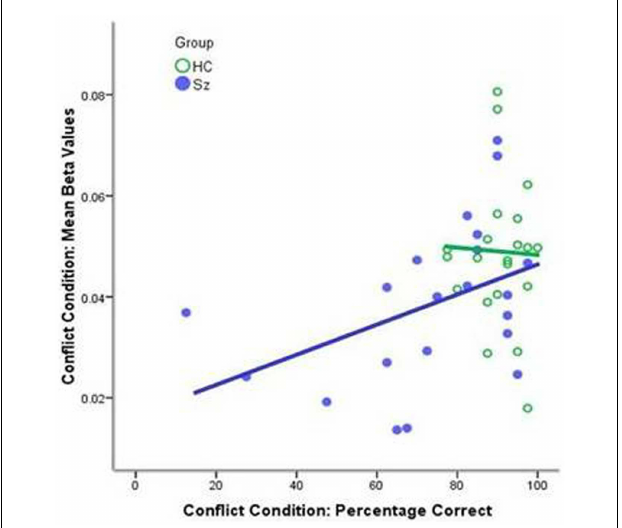
FIGURE 3 | Correlations between performance on the conflict condition and the mean beta values for the conflict condition for the whole mask .The schizophrenia group showed a significant correlation [ r (21) = 0.422; p < 0.05, blue line]; the healthy control group displayed uniformly high level of performance [ r (21) =− 0.04; p = 0.432, green